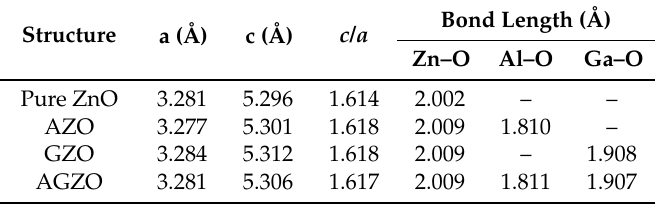
Table 1. Optimized lattice constants and bond lengths of Al/Ga-doped